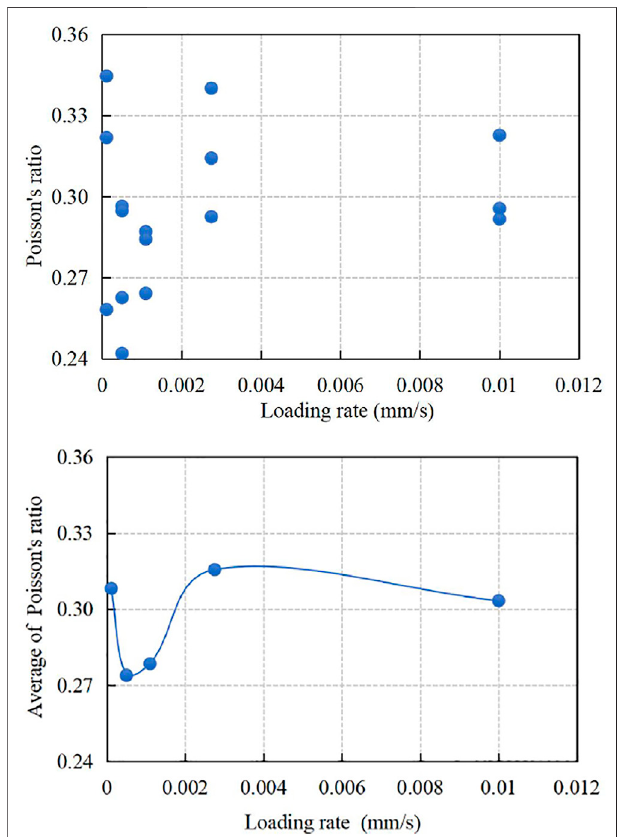
FIGURE 9 | Relationship between loading rate and Poisson ’ s